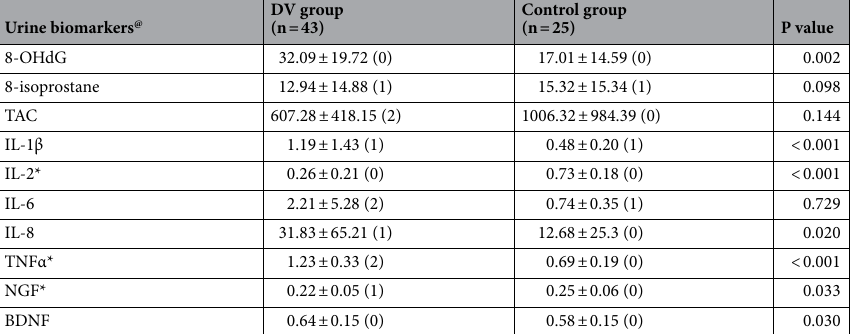
Table 2. Urine biomarker levels of patients with DV and controls. DV Dysfunctional voiding, 8‑OHdG 8-hydroxy-2-deoxyguanosine, TAC Total antioxidant capacity, TNFα Tumor necrosis factor alpha, NGF Nerve growth factor, BDNF Brain-derived neurotrophic factor. (): number of outliers. *: Mean values of the study group that were below the minimum detectable concentrations as per the assay manufacturer. @: units: all pg/ mL, except for ng/mL in 8-OHdG and mmol/μL in